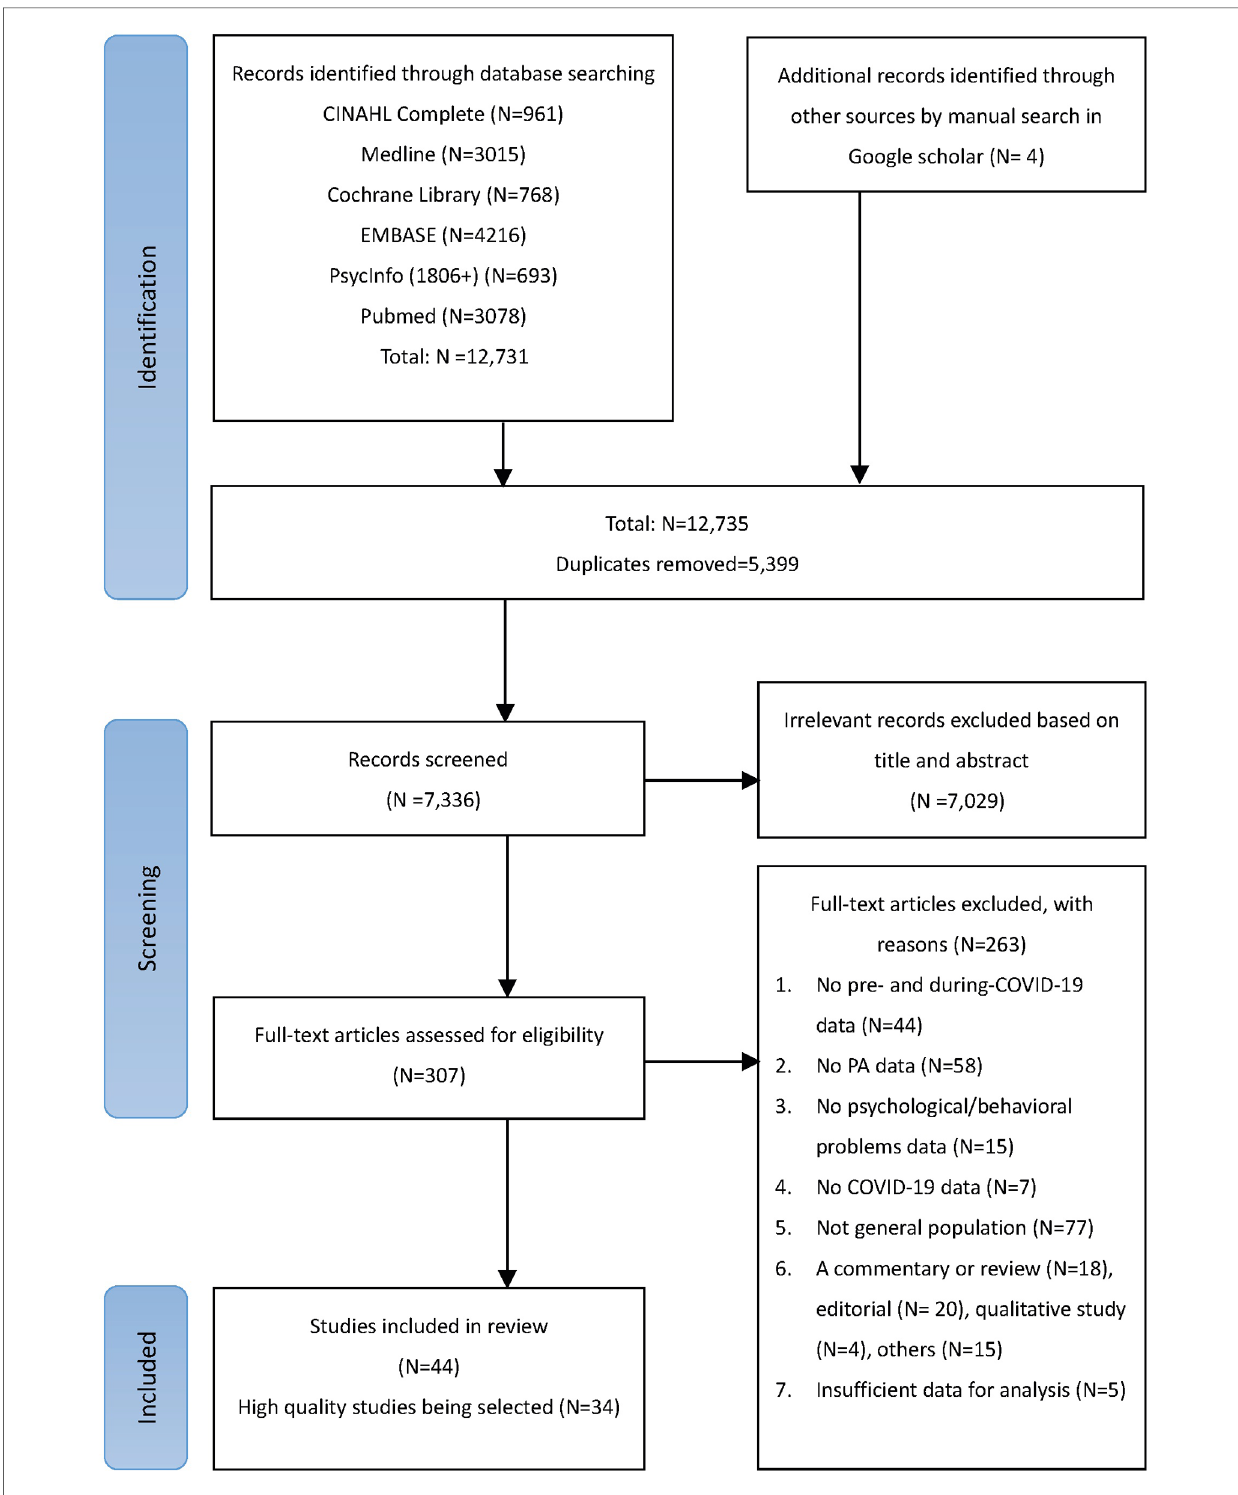
FIGURE 1 PRISMA fl ow chart of study selection in the systematic